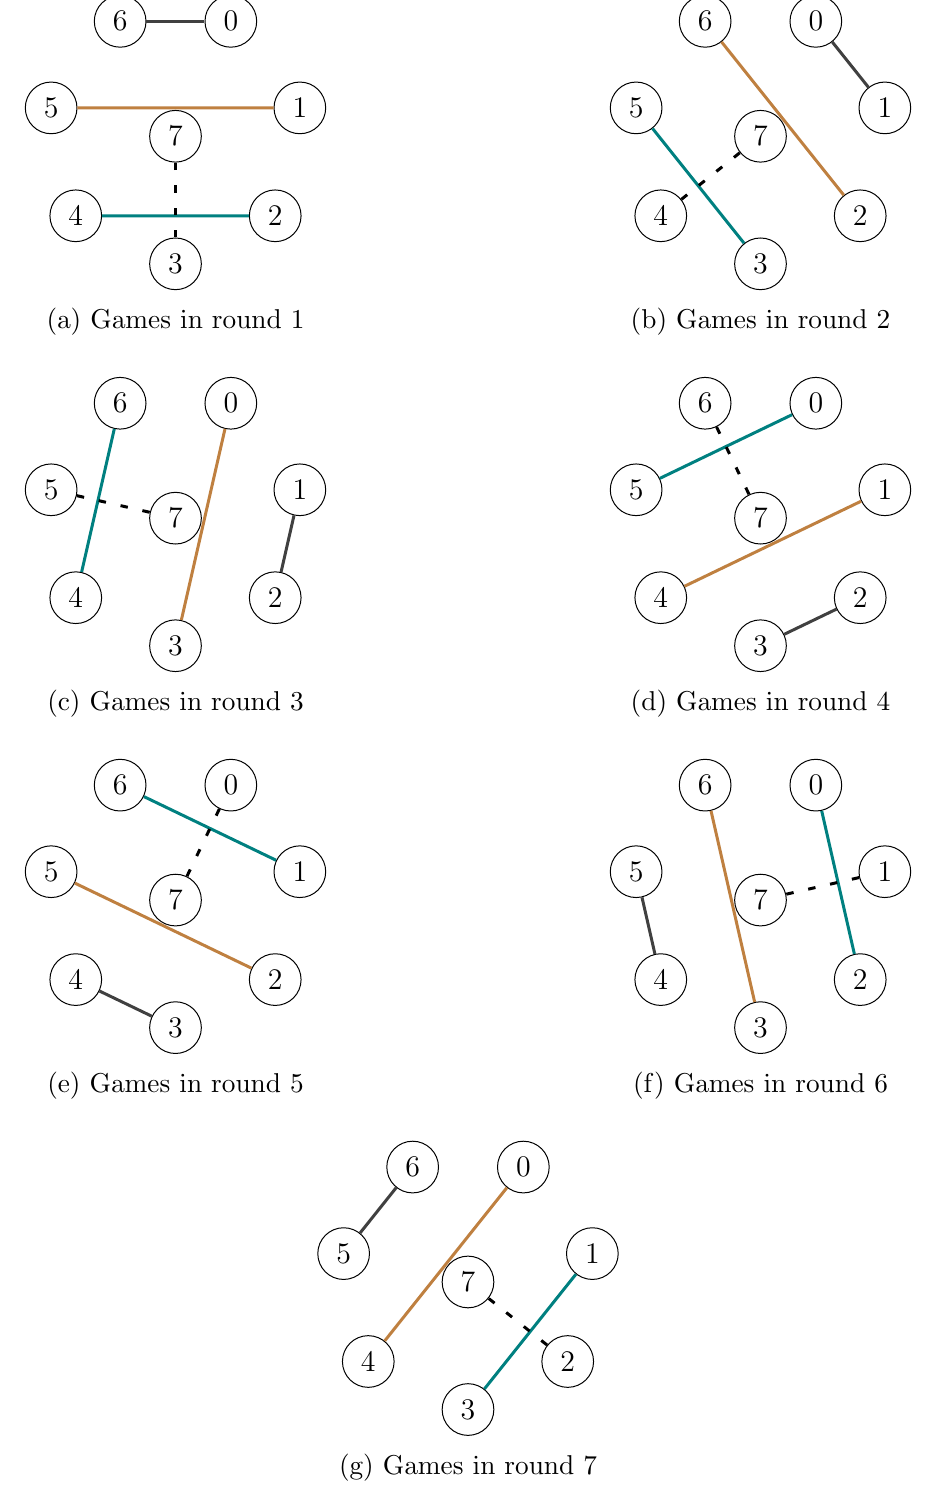
Figure 5: Feasible schedule of 8 teams based on a perfect rainbow matching of K •